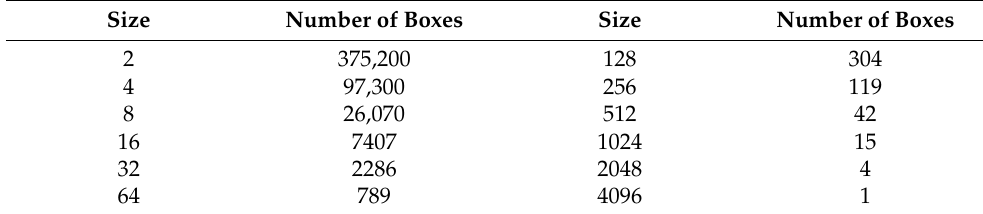
Table 2. List of size and number of boxes of an irregular